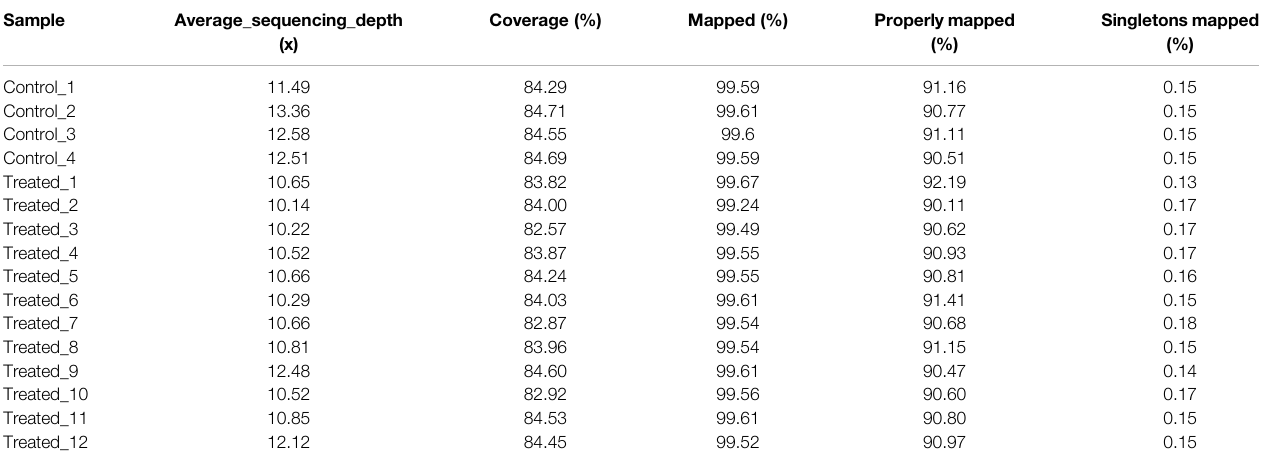
TABLE 3 | Summary of assembly